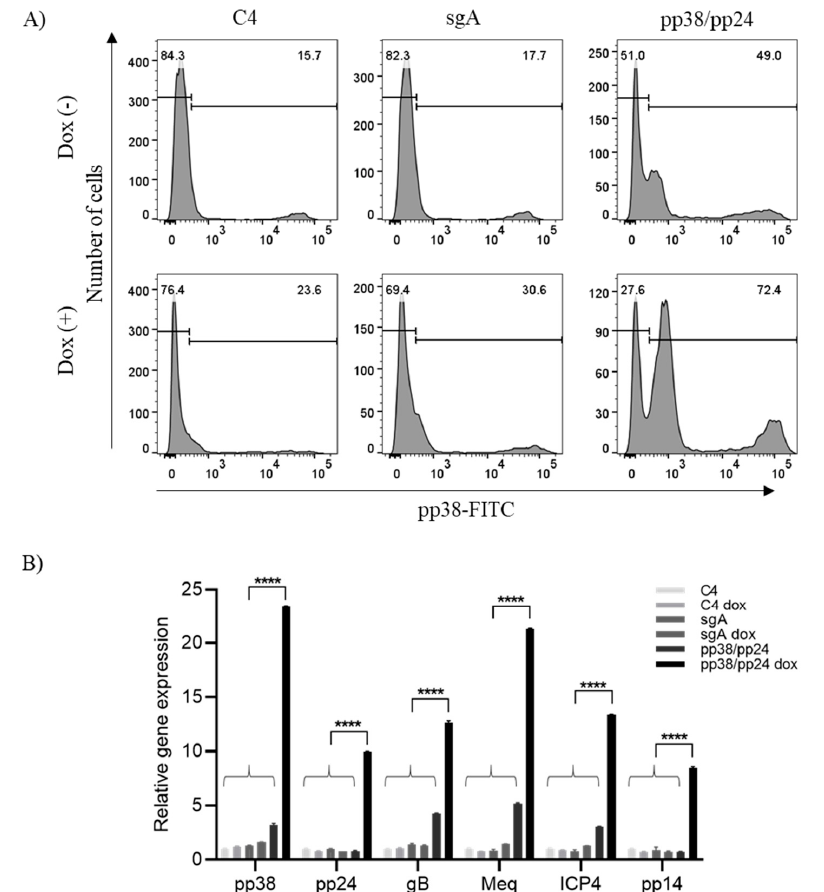
Figure 2. pp38/pp24 overexpression by CRISPRa manoeuvres the expression of other MDV viral genes. ( A ) Quantification of pp38-expressing C4 cells following CRISPRa using flow cytometry. C4 cells were transfected with sgA or pp38/pp24-specific gRNAs in the presence (C4 dox, sgA dox and pp38/pp24 dox) or absence of doxycycline (C4, sgA and pp38/pp24). The cells were incubated with anti-pp38 mAb BD1 followed by Alexa fluor 488 secondary antibody 24 h pt. The labelled cells were subjected to flow cytometry analysis. The percentage of the pp38 –ve and pp38 +ve populations are shown for each population. ( B ) RT-qPCR analysis of MDV viral gene expression in pp38/pp24-overexpressed population (pp38/pp24 dox) and the control cells. C4 cells were transfected with sgA or pp38/pp24-specific gRNAs in presence (C4 dox, sgA dox and pp38/pp24 dox) or absence of doxycycline (C4, sgA and pp38/pp24). RNA was extracted 24 h pt, followed by RT-qPCR analysis using gene specific primers and probes where applicable. The histogram representing the relative gene expression of pp38, pp24, gB, meq, ICP4 and pp14 in C4 cells with different treatments. Expression was normalized to the host gene GAPDH. The relative fold change was compared with C4 cells and expressed as fold change (2 − ∆∆ CT ). Asterisk indicates statistically significant differences between pp38/pp24-overexpressing cells and each of the control cells. ****, p < 0.0001. The increase in pp38 expression was also reflected by the pp38 transcript level (Figure 2B). RT-qPCR analysis of the control gRNA sgA-transfected C4 cells with and without doxycycline showed a basal level of pp38/pp24 mRNA expression. However, pp38/pp24-specific gRNA-transfected C4 cells induced with doxycycline showed robust induction with ~24-fold increase of pp38 mRNA and 10-fold increase of pp24 mRNA, compared to only ~3-fold modest increase of pp38 and no change for pp24 observed in the non-induced doxycycline-negative